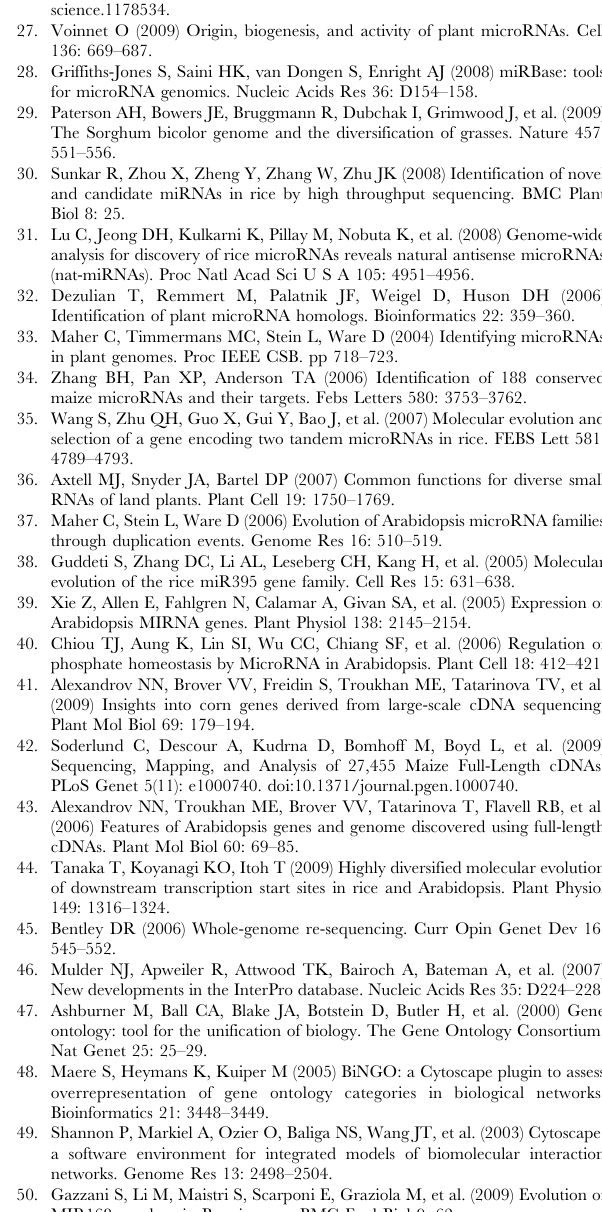
Table S11 Maize miRNA gene diversity.